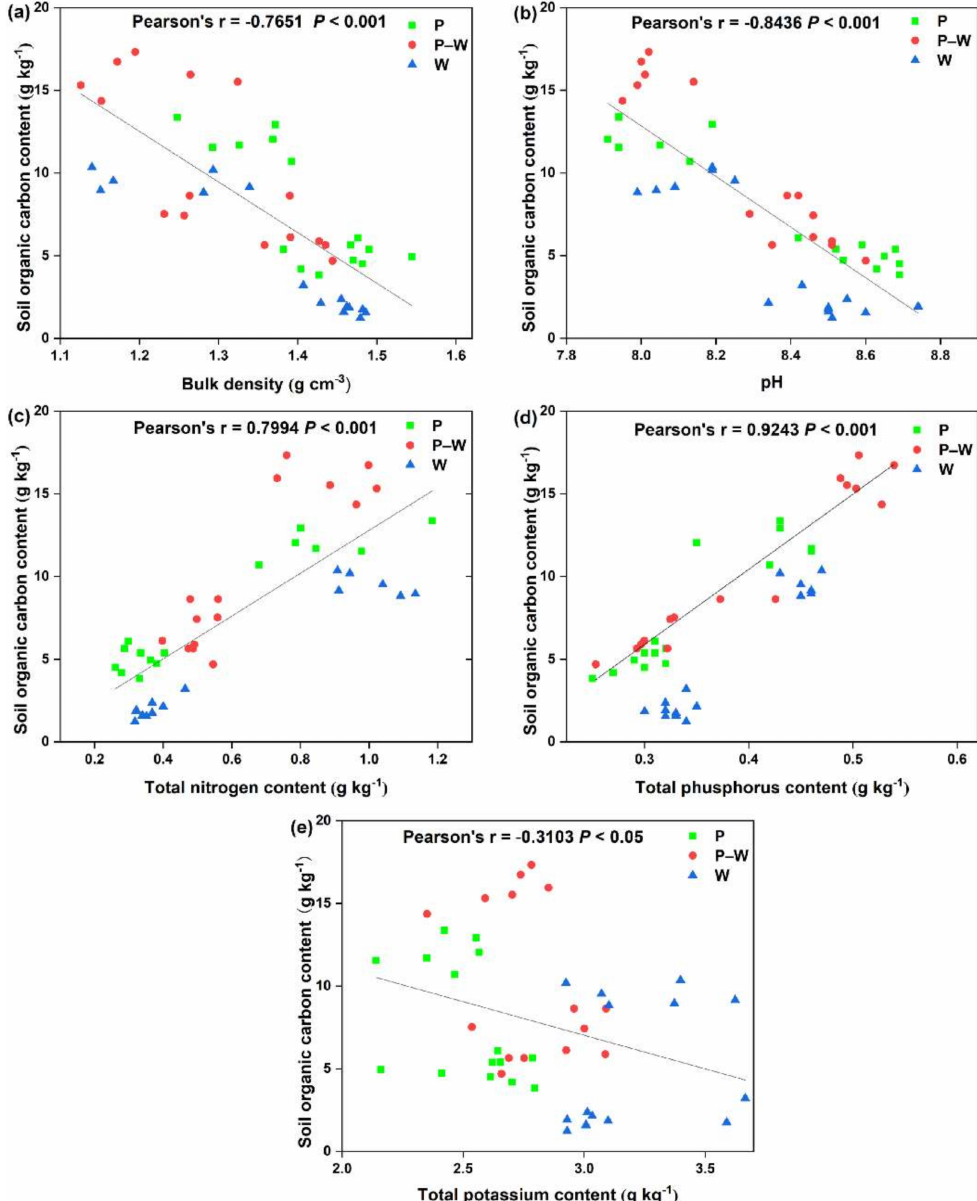
Figure 6. Relationships of the SOC content and BD ( a ), pH ( b ), TN ( c ), TP ( d ) and TK ( e ). P, poplar plantation system; P–W, wheat field system after deforestation of a poplar plantation; W, wheat field